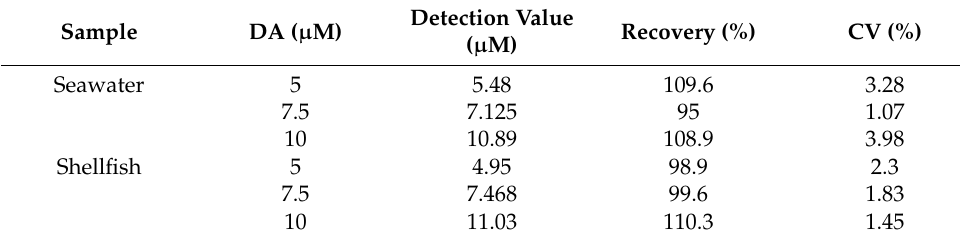
Table 3. Detection of DA in real samples ( n = 3).